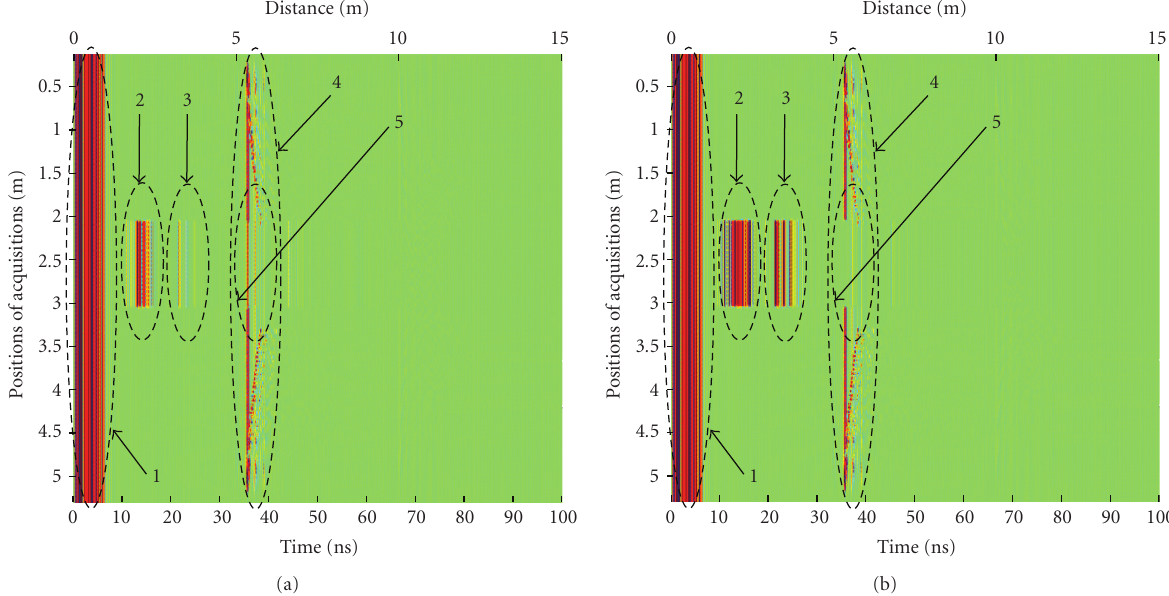
Figure 22: TWRI results in the configuration in Figure 21 according to (a) a metallic target and (b) a dielectric target.